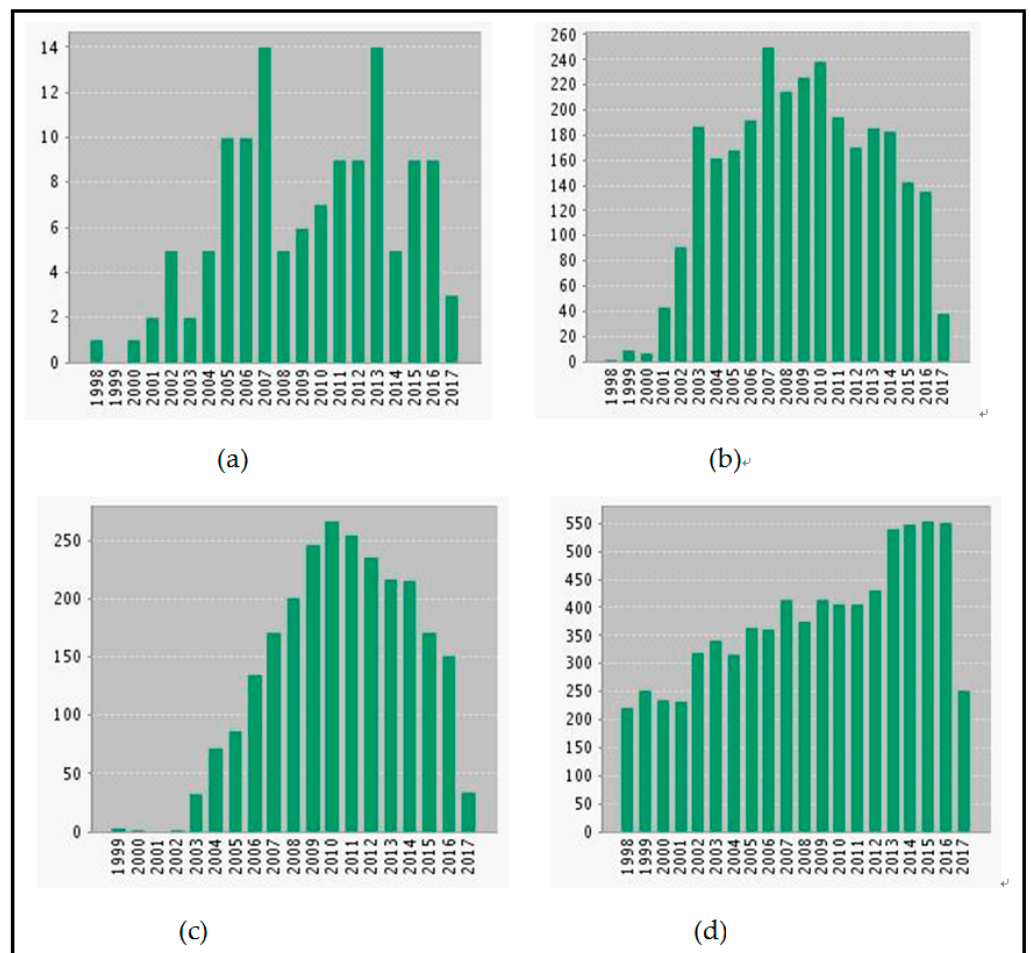
Figure 9. Yearly publications from 1998 to 2017 indexed by Web of Knowledge on: ( a ) CORONA satellite imagery; ( b ) IKONOS; ( c ) QuickBird; and ( d ) only aerial photograph. The search was conducted